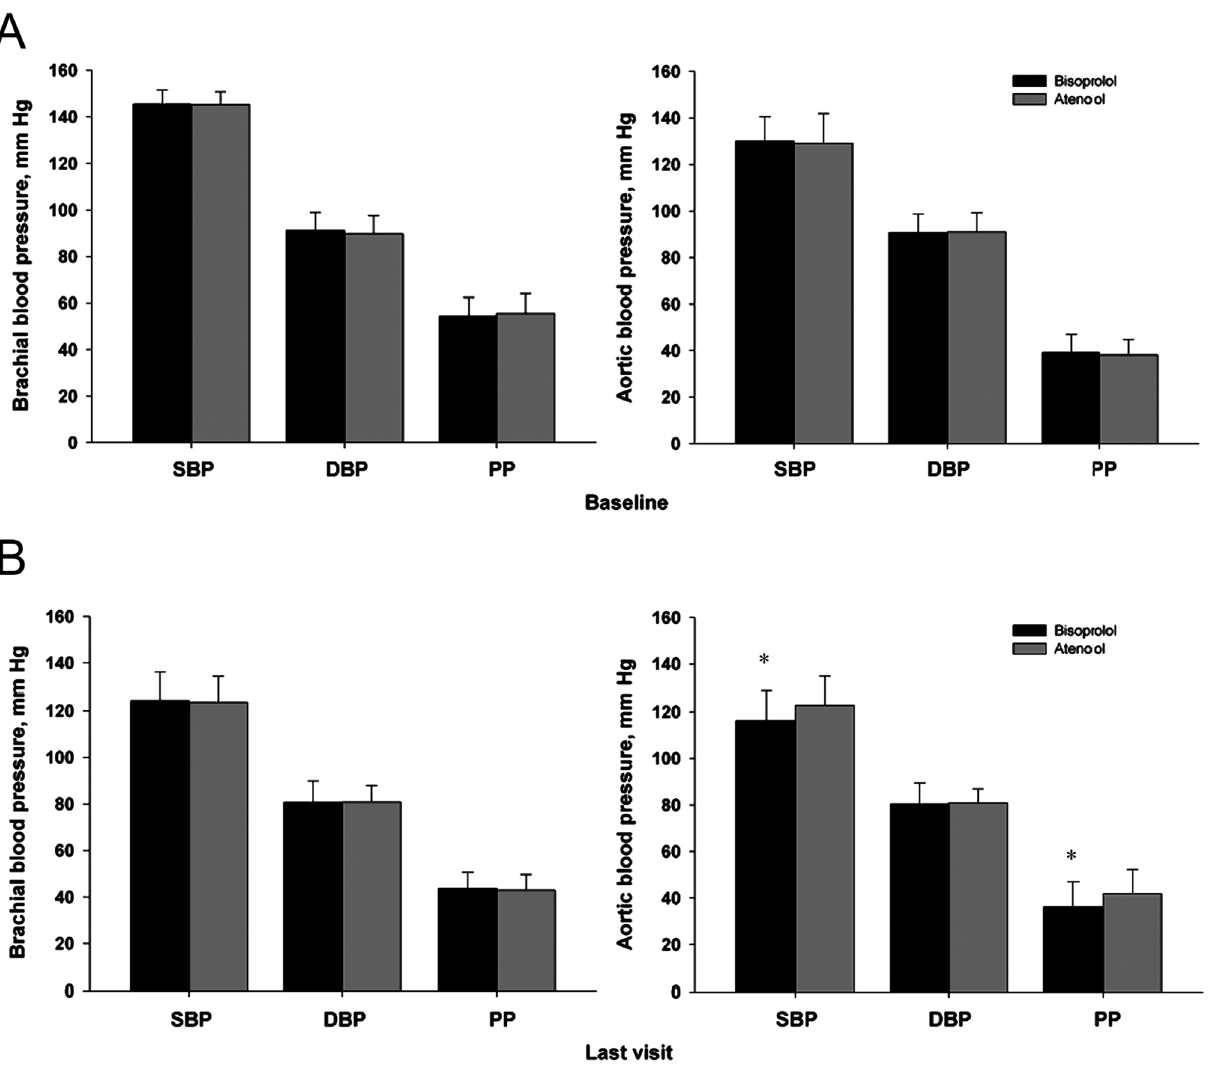
Figure 2. (A) Comparison of hemodynamic parameters of study subjects at baseline. (B) Comparison of hemodynamic parameters of study subjects at the end of the treatment period.* P , 0.01.